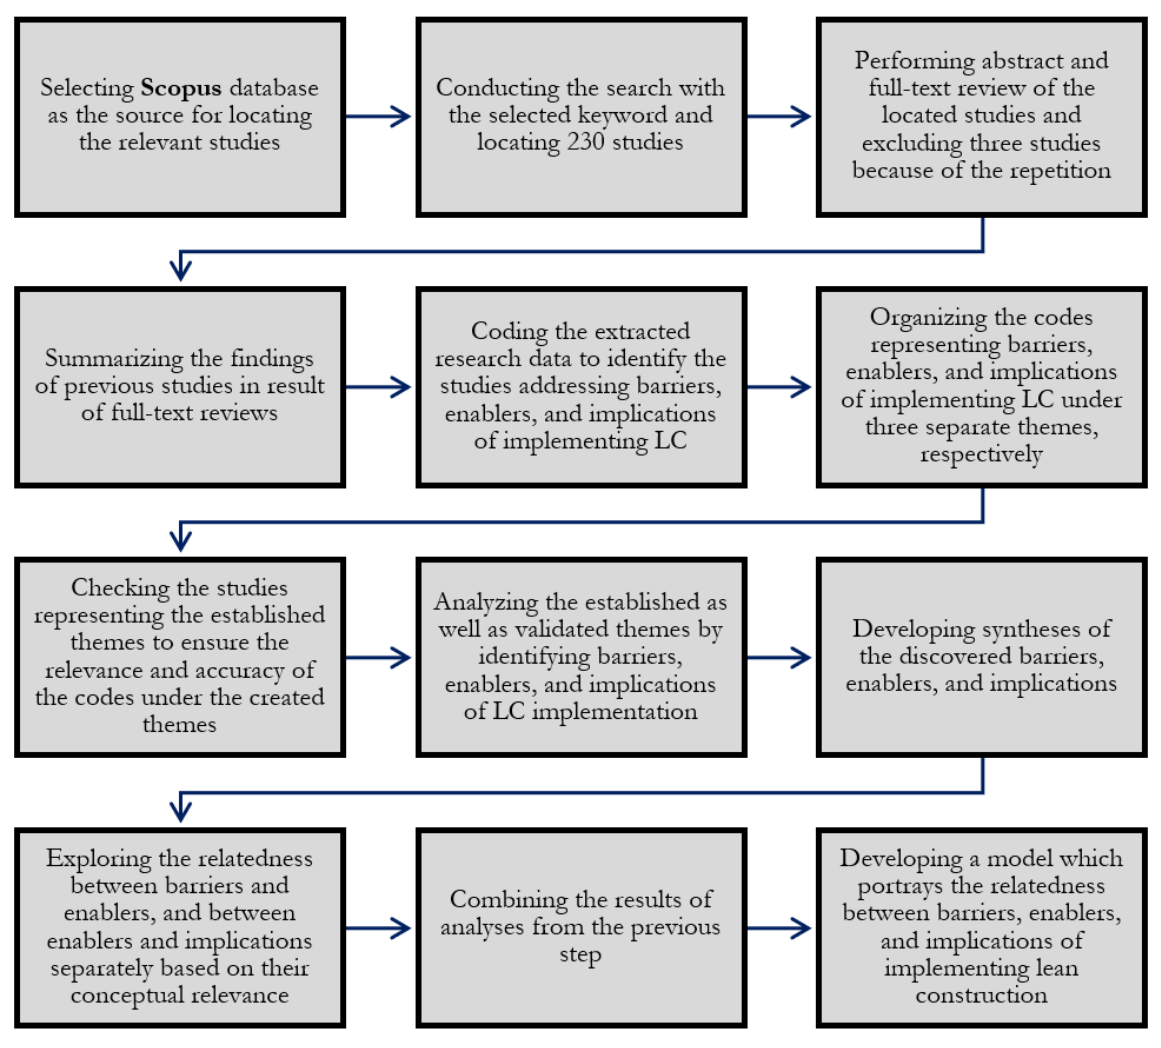
Figure 1. Research